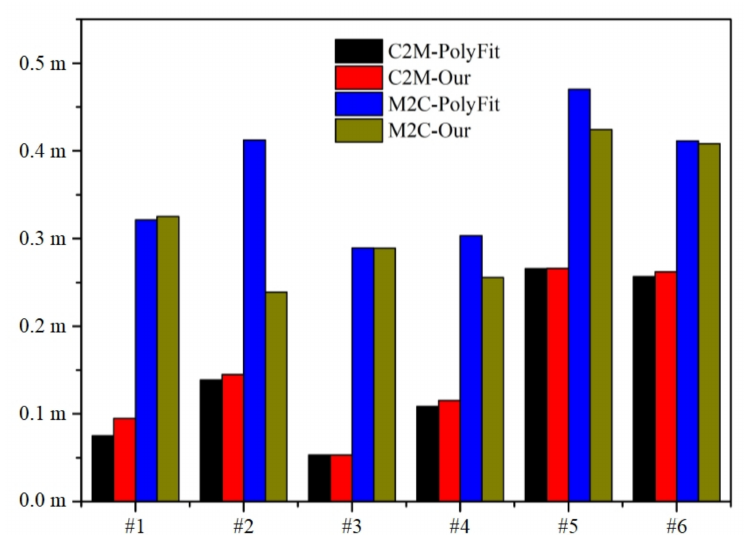
Figure 13. Mean C2M and M2C distances from Buildings #1 to #6 generated by three-dimensional (3D) models from PolyFit [10] and the proposed